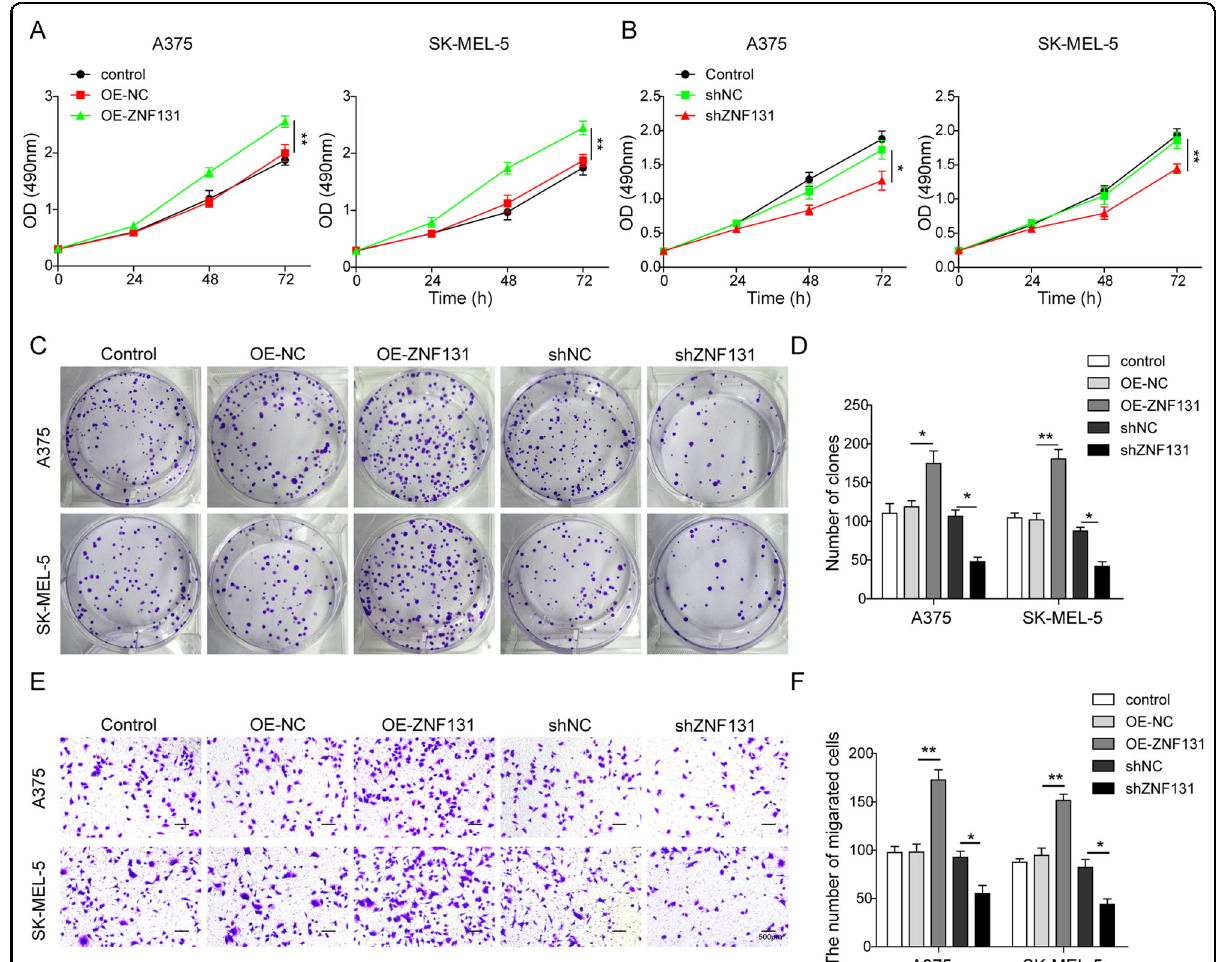
Fig. 6 ZNF131 promoted melanoma cell proliferation, migration, and colony formation ability. A MTT assay of the cells after transfected with OE-NC and OE-ZNF131, respectively. B MTT assay of the cells after transfected with shNC and shZNF131, respectively. C , D The colony formation assay of the cells after transfected with control, OE-NC, OE-ZNF131, shNC, and shZNF131, respectively. E , F Migration ability of the cells after transfected with control, OE-NC, OE-ZNF131, shNC, and shZNF131 evaluated by transwell assay. The mean ± SD in the graph shows the relative levels from three replicates. * p < 0.05, ** p <